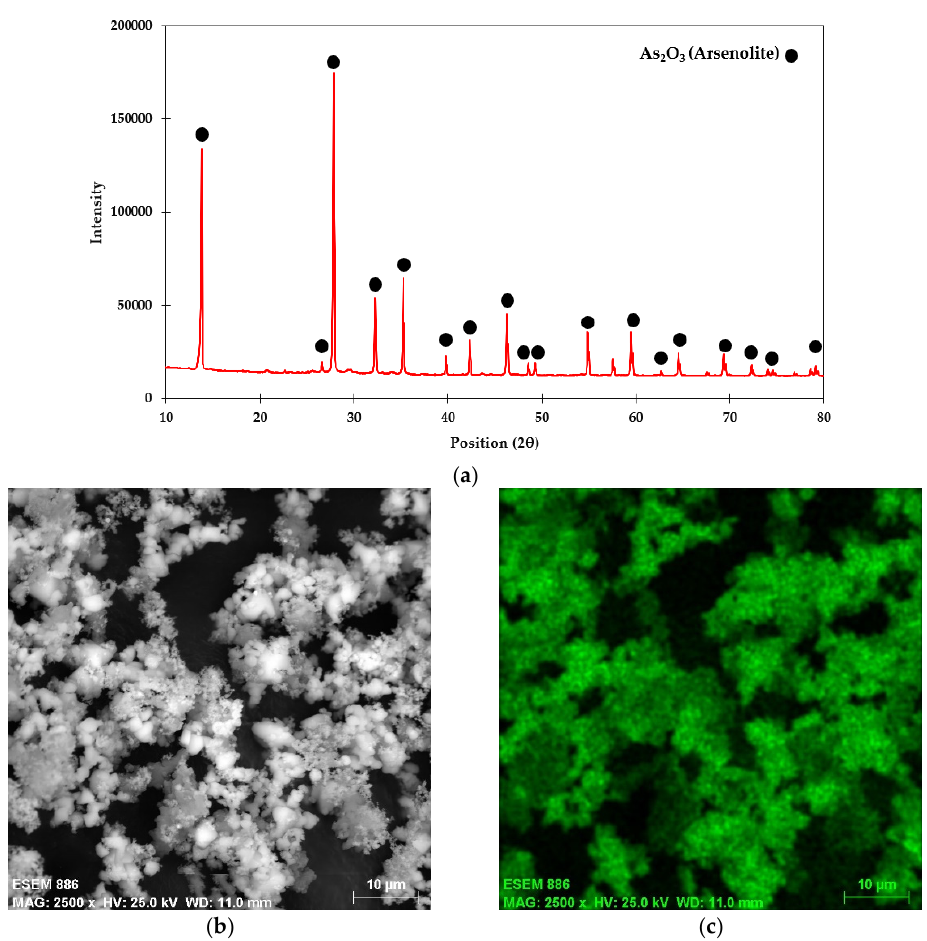
Figure 2. ( a ) XRD pattern, ( b ) SEM image, and ( c ) arsenic EDS of smelter high-arsenic flue dust.